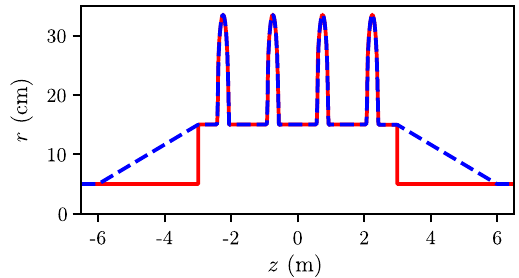
FIG. 9. The full structure of four single-cell cavities with tapers used in simulations.